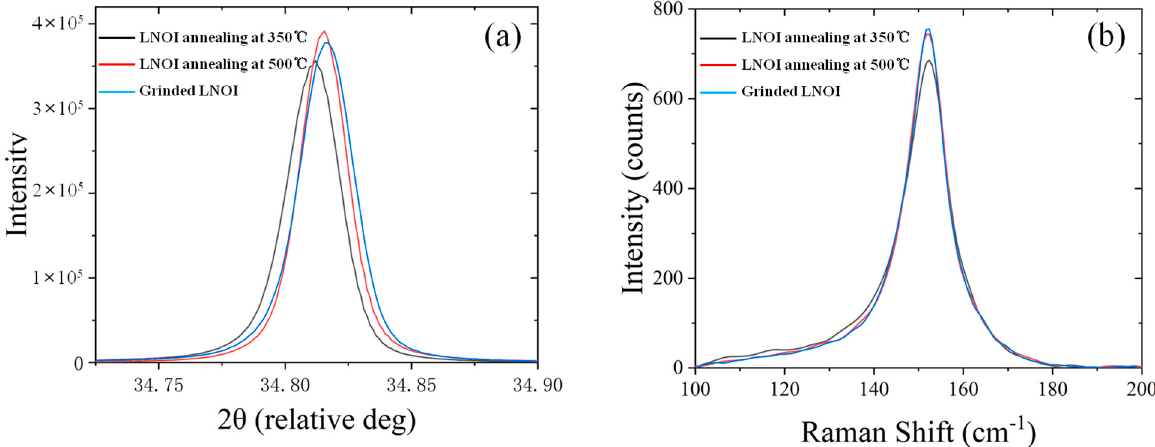
Figure 5. ( a ) Diffraction peak of LNOI measured by HRXRD. ( b ) Polarized Raman spectra of LNOI at 153 cm − 1 .